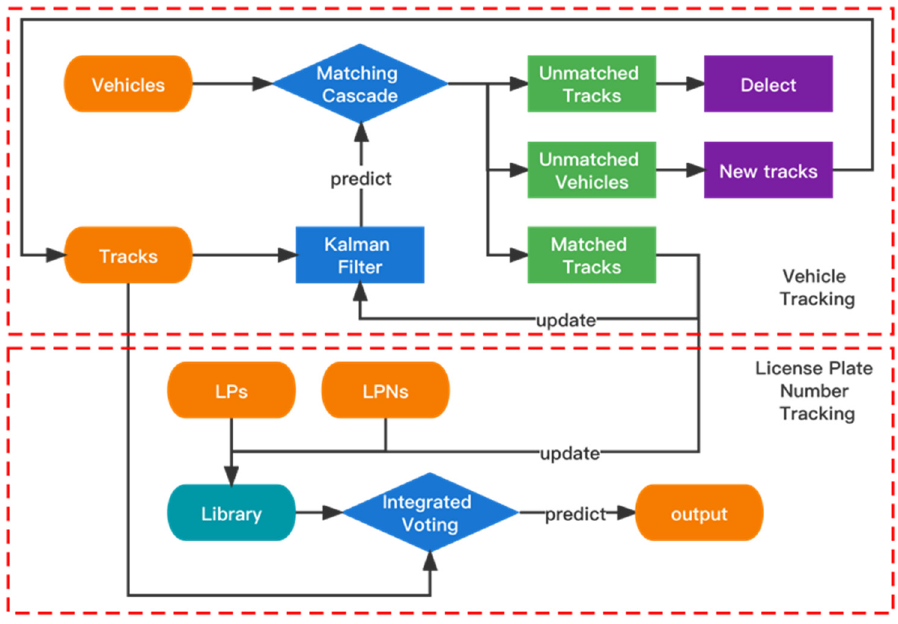
Figure 5. The structure of the proposed